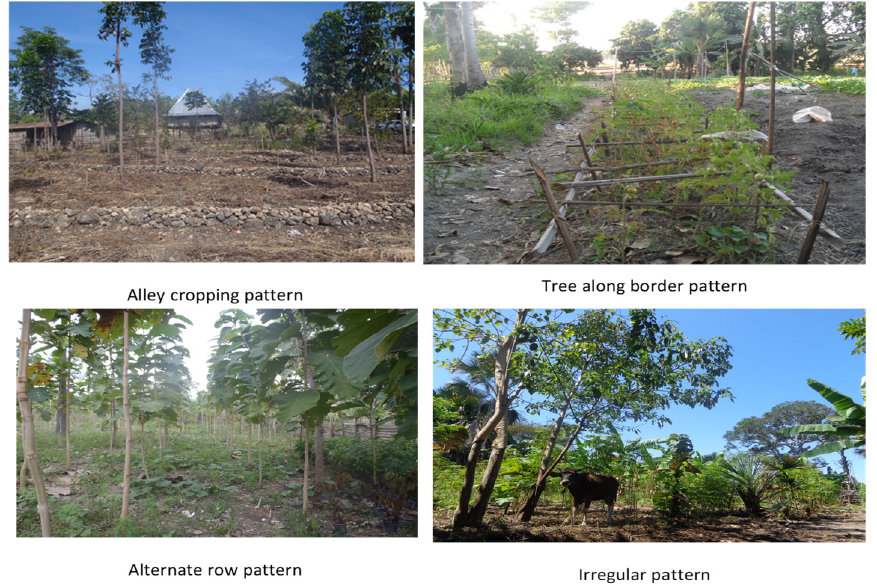
Figure 1. Various agroforestry models in Timor-Leste (Photos: Adelino/GDFCIP). Fukuoka, a natural farming system, was introduced in Timor-Leste to plant trees in hilly agricultural marginal lands. About 200,000 Fukuoka seedballs were produced and distributed to rehabilitate larger vulnerable slopes previously damaged by slash-and-burn agriculture, erosion, and other forms of ecosystem degradation in hilly landscapes [32]. Fukuoka is a non-destructive type of reforestation method that can be used in hilly